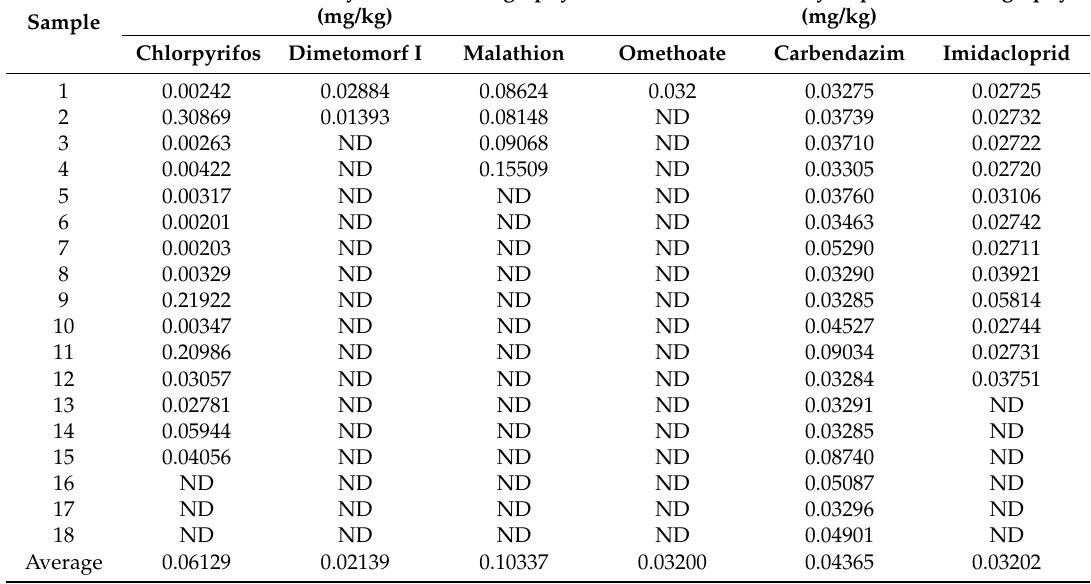
Table 4. Residual concentrations of pesticides observed in the Gathering Center Supplied by non-certified